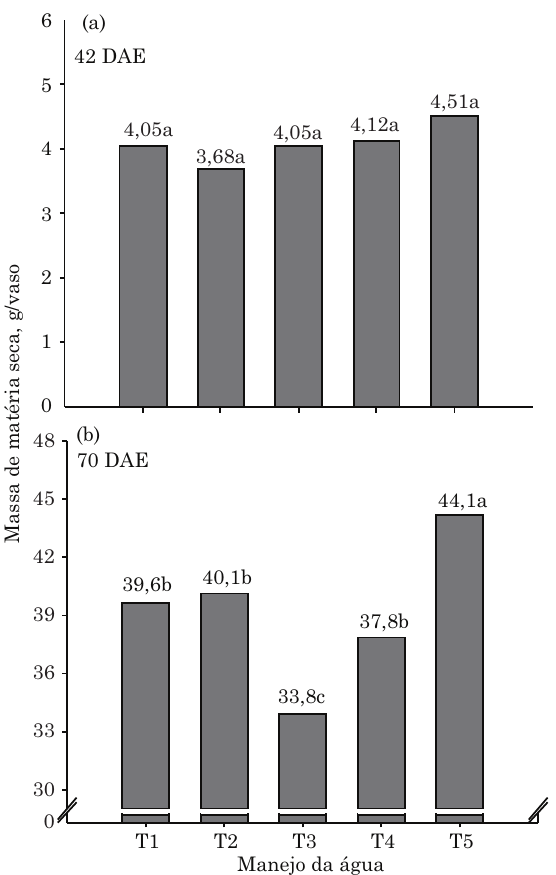
Figura 5. Percentual de folhas com sintomas de toxidez por ferro aos 50, 60 e 70 dias, após a emergência (DAE) do arroz cultivado em diferenciados manejos da água. # Não apresentou sintomas visuais de toxidez.